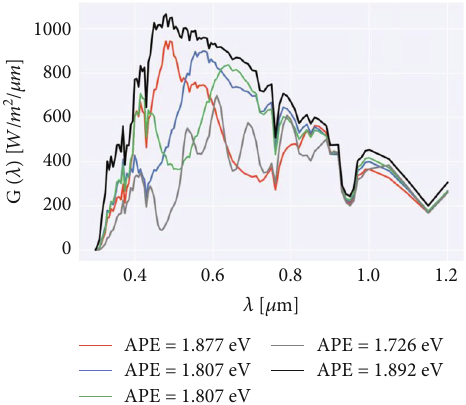
Figure 4: Spectral solar irradiance G ð λ Þ estimated with Leckner ’ s model [12] emerging from the coating layer. The curve color corresponds to the cell color except the white cell for which SR ð λ Þ is displayed in gray. The curve in black corresponds to AM1.5G solar spectrum. The characteristic signature of each spectrum measured by the average photon energy (APE) (Equation (6) is presented.